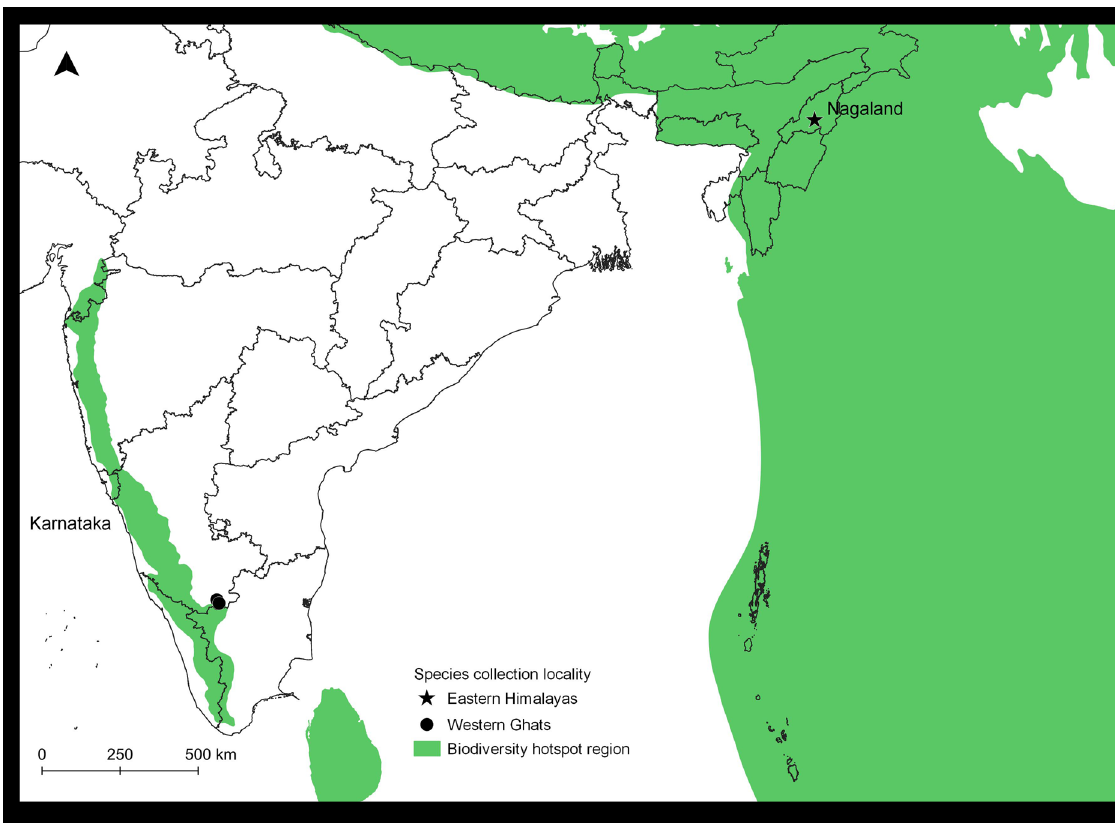
Fig. 21. Collection localities of Soliga ecarinata gen. et sp.